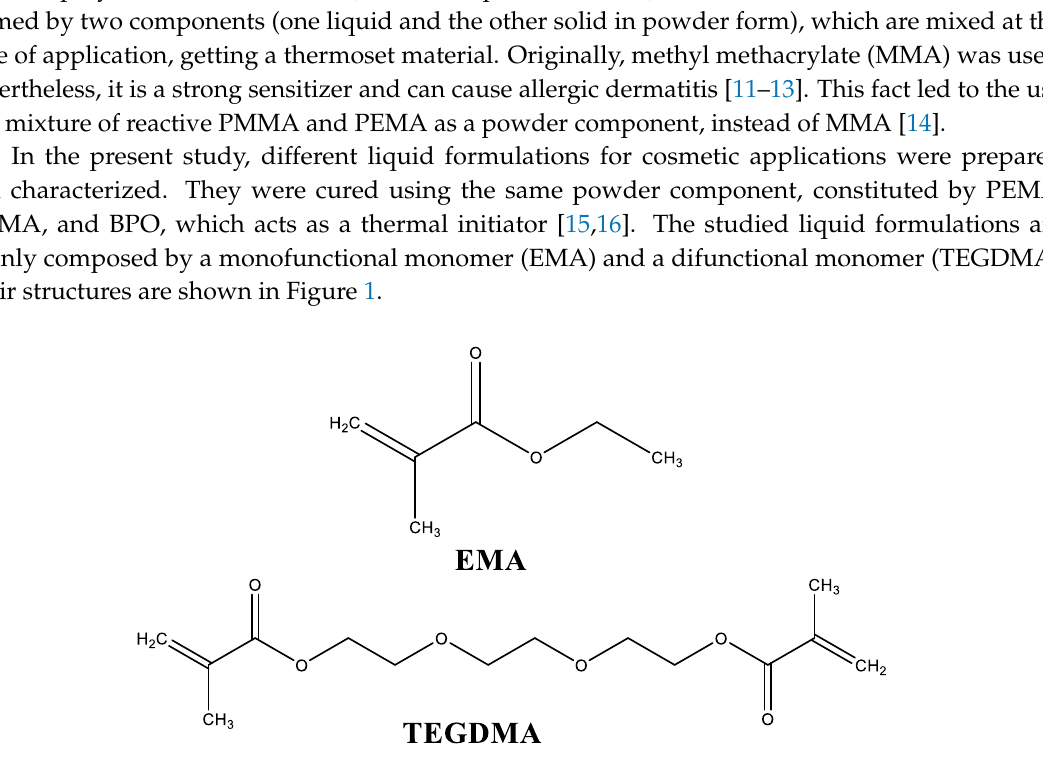
Figure 1. Structures of the main components of liquid formulations. EMA: ethyl methacrylate; TEGDMA: triethylene glycol dimethacrylate.